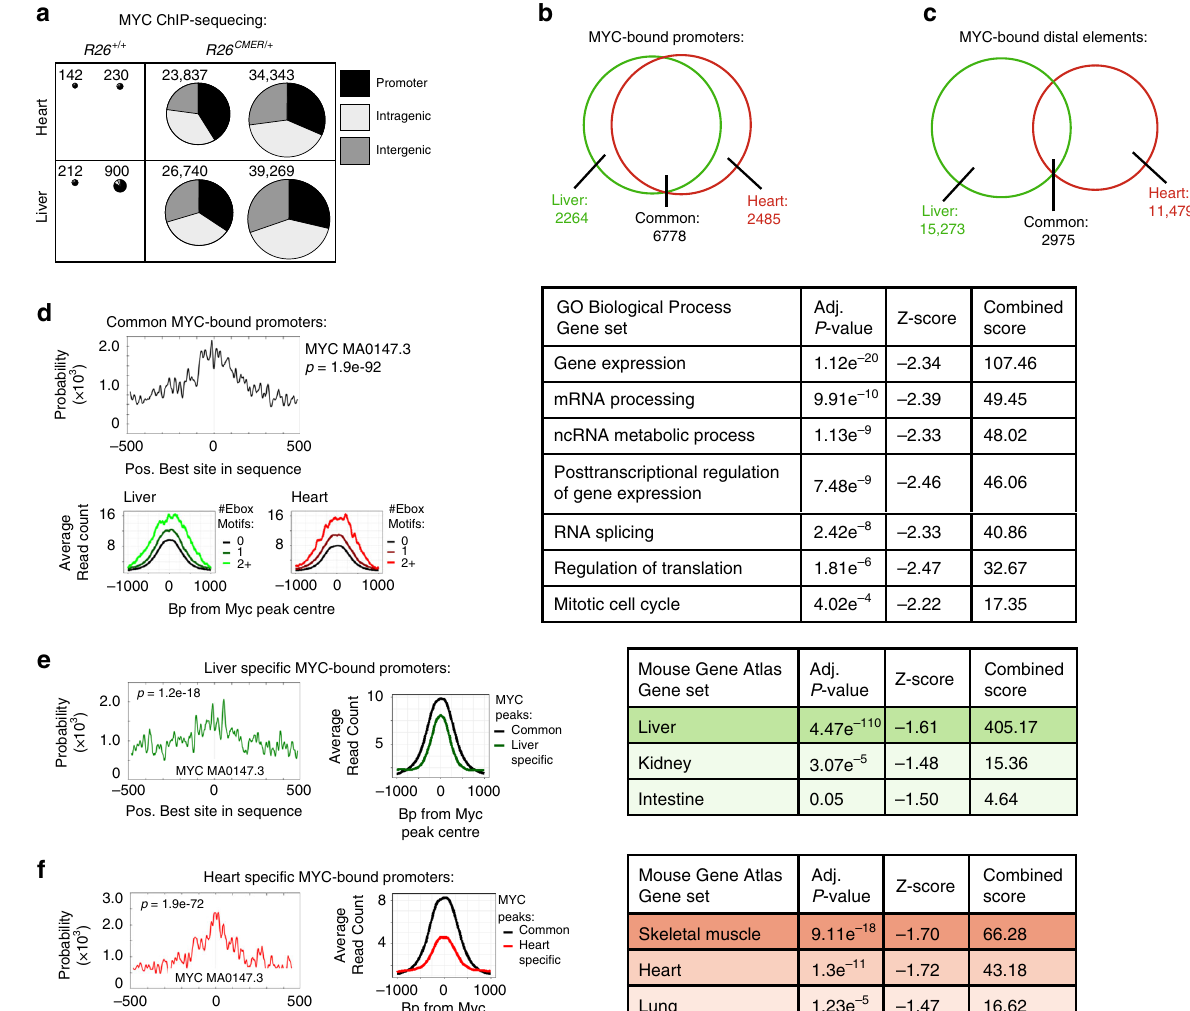
Fig. 2 Myc binding differs between tissues. a The number of Myc peaks and their location (promoter, intragenic and intergenic). Replicates are derived from independent mice. b Venn diagram of the overlap of peaks called within promoter regions ( − 2 kb to + 1 kb from the nearest TSS). c Venn diagram of the overlap of peaks called within distal elements. d Motif probability curves for common Myc-bound promoters show the probability of an E-box consensus sequence occurring at a given position relative to the Myc ChIP peak at each common promoter site, as determined by CentriMo (top left). Average read count of Myc peaks at common promoters containing 0, 1 or >2 E-box motifs within 1000 bp from the peak centre in liver and heart chromatin (bottom left). Selected signi fi cant GO Biological Process Gene sets that overlap with common Myc-bound promoter elements (right). e Motif probability curves for liver-speci fi c promoters show the probability of an E-box consensus sequence occurring at a given position relative to the Myc ChIP peak at each liver-speci fi c promoter site, as determined by CentriMo (left). Average read count of Myc peaks shown at common (black) and liver-speci fi c (green) promoter sites (centre). Selected signi fi cant Mouse Gene Atlas Gene sets are shown that overlap with liver-speci fi c Myc-bound promoter elements (right). f As for e but for heart-speci fi c Myc-bound promoters bound by Myc only in the heart. Signi fi cant Mouse Gene Atlas Gene sets are shown that overlap with heart-speci fi c Myc-bound promoter elements (right). All analysis determined by Myc ChIP sequencing performed from hearts and livers harvested from wild-type ( R26 + / + n = 2) and R26 CMER/ + ( n = 2) mice at 4 h post administration of 4-OHT. MemeSuite Centrimo computed P -values are derived by a binomial test. Enrichr computed P -value (Fisher ’ s exact test), Z -score (modi fi ed Fisher ’ s exact test to determine deviation from an expected rank) and combined score ( C = ln( P ) × Z ) are shown. Source data are provided as a Source Data fi